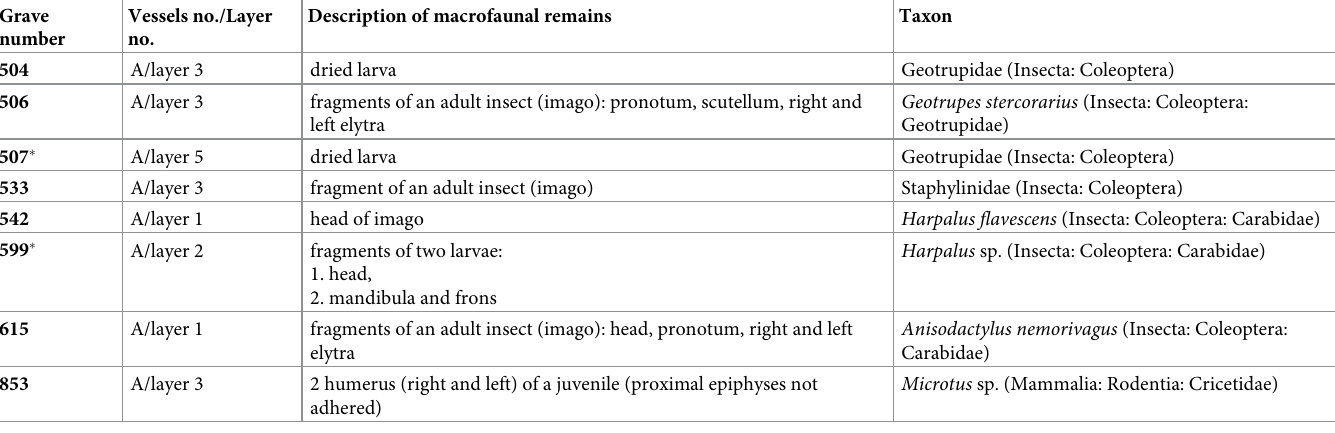
Table 1. Identified macrofaunal remains from various exploration levels (layers) within the urns from the Lusatian culture cemetery in Wto´rek, Greater Poland, Poland. Grave Vessels no./Layer number